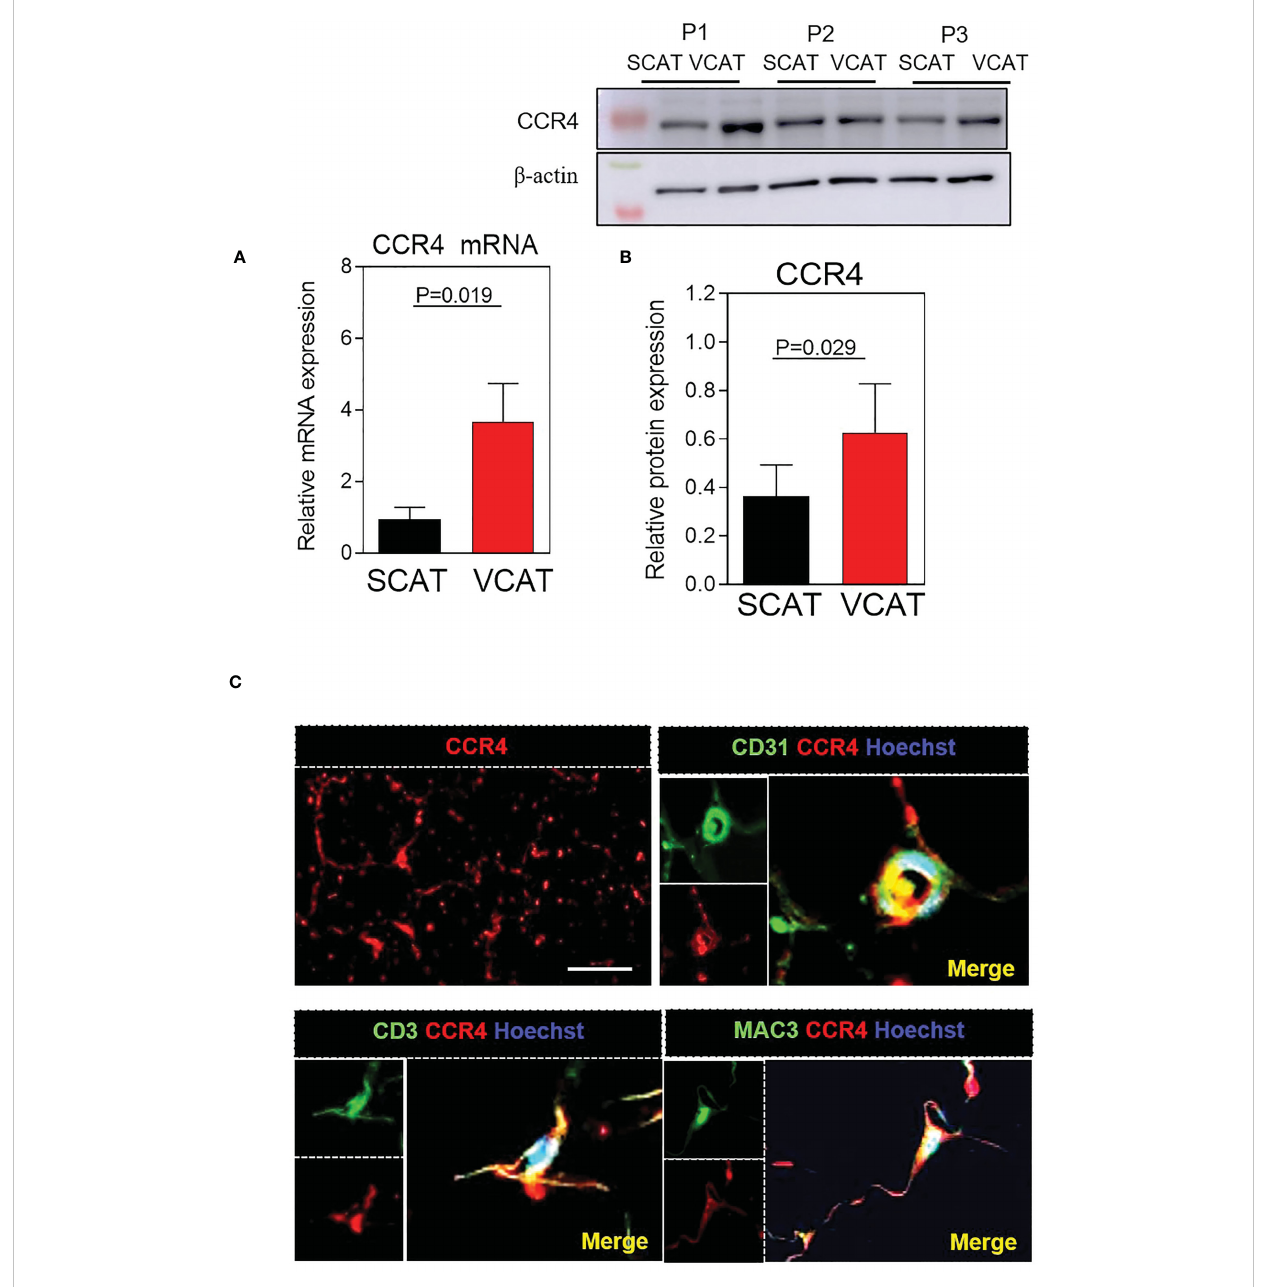
FIGURE 3 CCR4 expression is increased in VCAT from morbid obese patients. (A) Relative quanti fi cation of CCR4 mRNA levels. Values are expressed as mean ± SEM (n = 33); (B) Western blot analysis of CCR4 relative protein expression to b -actin in paired and SCAT and VCAT samples. Representative western blots are shown from three different patients (P1 – 3). Data represent the mean ± SEM of protein densitometry. Comparison between groups were made by Wilcoxon matched-pair signed-rank test. (C) Immuno fl uorescence representative images showing CCR4 expression in VCAT. Colocalization of CCR4 with CD3 (lymphocytes), CD31 (endothelial cells) and Mac-3 (macrophages) in VCAT. Immunoreactivity was visualized using Alexa Fluor 594 (CCR4, red) and Alexa Fluor 488 (CD31, CD3, Mac-3, green ) secondary antibodies. Scale bar, 50 m m. Nuclei were stained with Hoechst ( blue